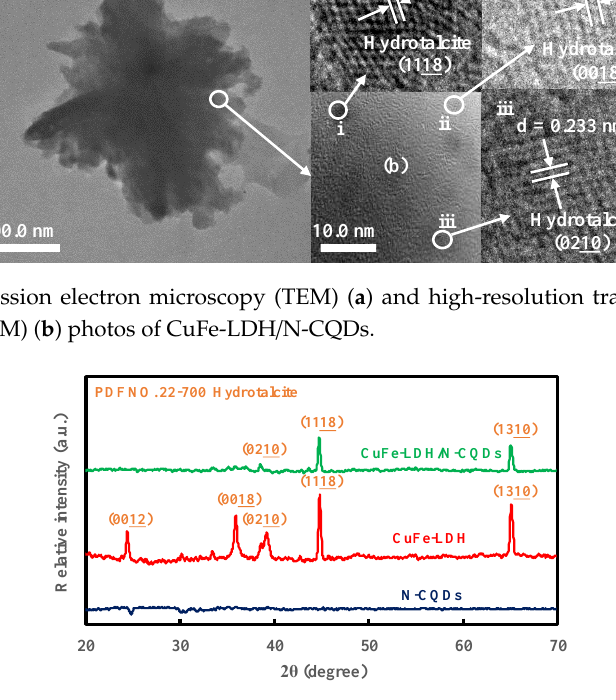
Figure 2. X-ray powder diffraction (XRD) spectra of N-CQDs, CuFe-LDH and CuFe-LDH/N-CQDs.